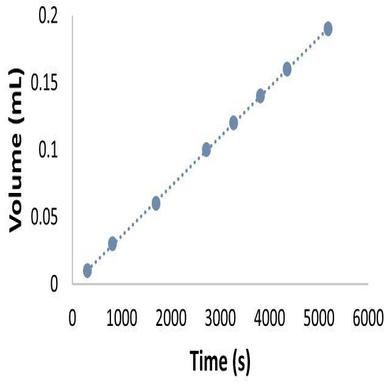
Time dependence of closed half-cell volume in measurements of osmosis using CEM Type 10 Fujifilm. The solutions were 1 M and 2 M NaCl.